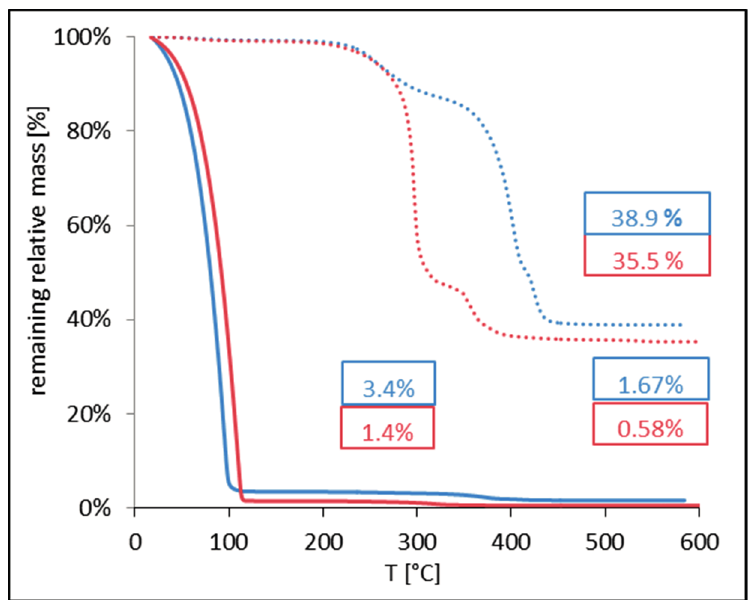
Figure 5. TGA curves of aqueous dispersions (full line) and dried particles (dotted line) of Sample A (blue) and Sample B